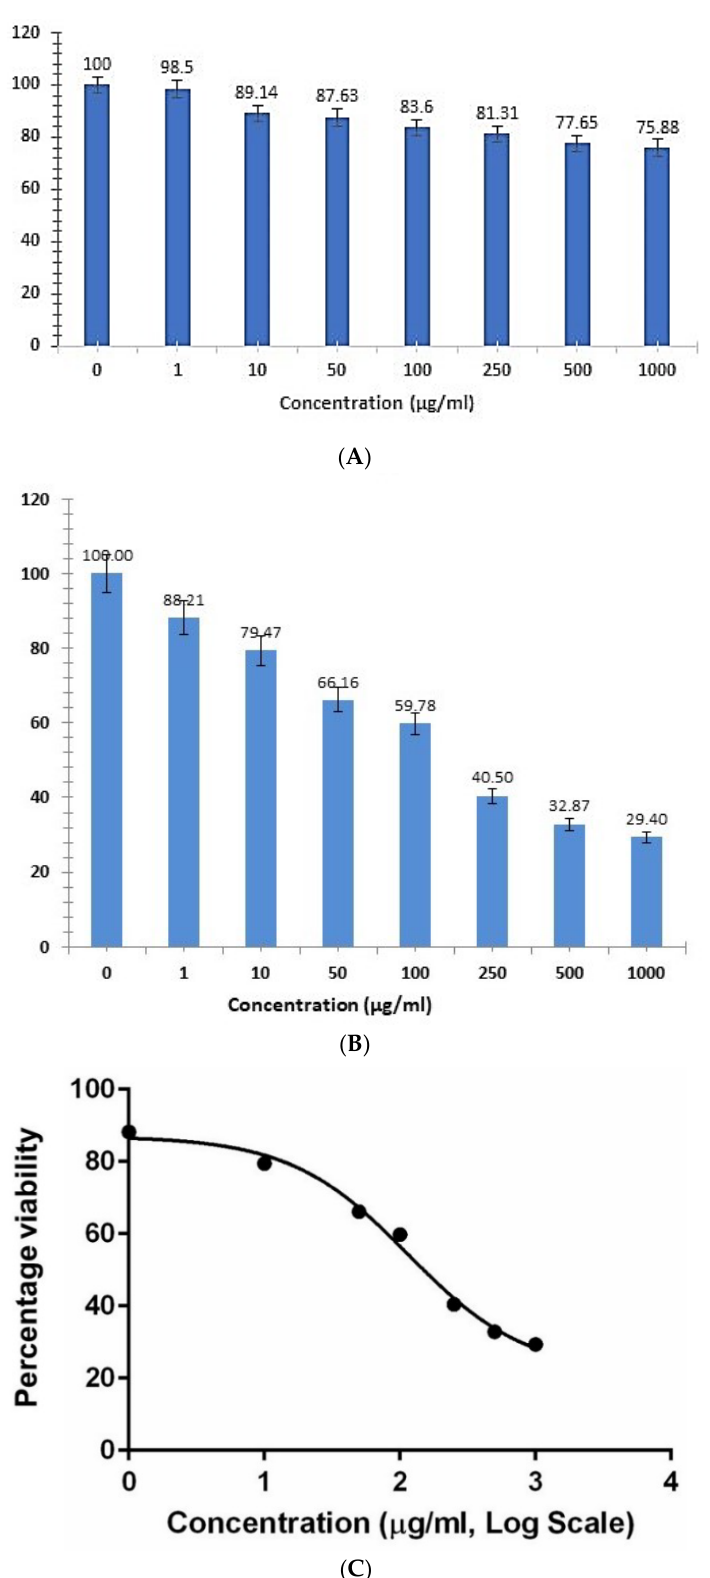
Figure 7. NRU assay depicting insignifcant increase in cytotoxicity in Vero cells (Normal cell line, ( A )) and dose-dependent increased cytotoxicity in HT-29 cell lines ( B ). The data are presented as a percentage of viable cells compared to the untreated control (DMSO) cells, and estimated IC50 value was 115.2 µg/mL ( C ).